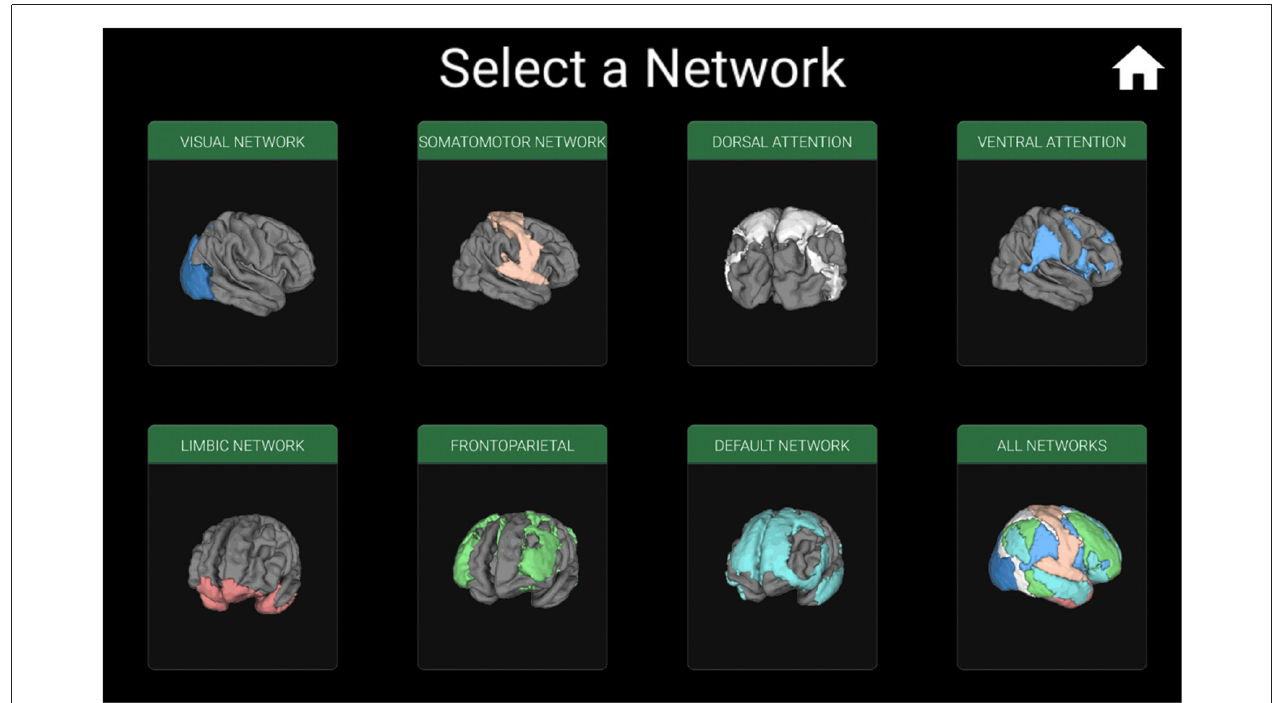
FIGURE 2 | Window for selecting the functional connectivity network which will be displayed individually, or all networks on a single brain. For example, iBraiN2 will show the window in Figure 3 if the user selects “All Networks”, and the visual connectivity network (Yeo et al., 2011) from Figure 4 will appear if the user touches the “Visual Network”